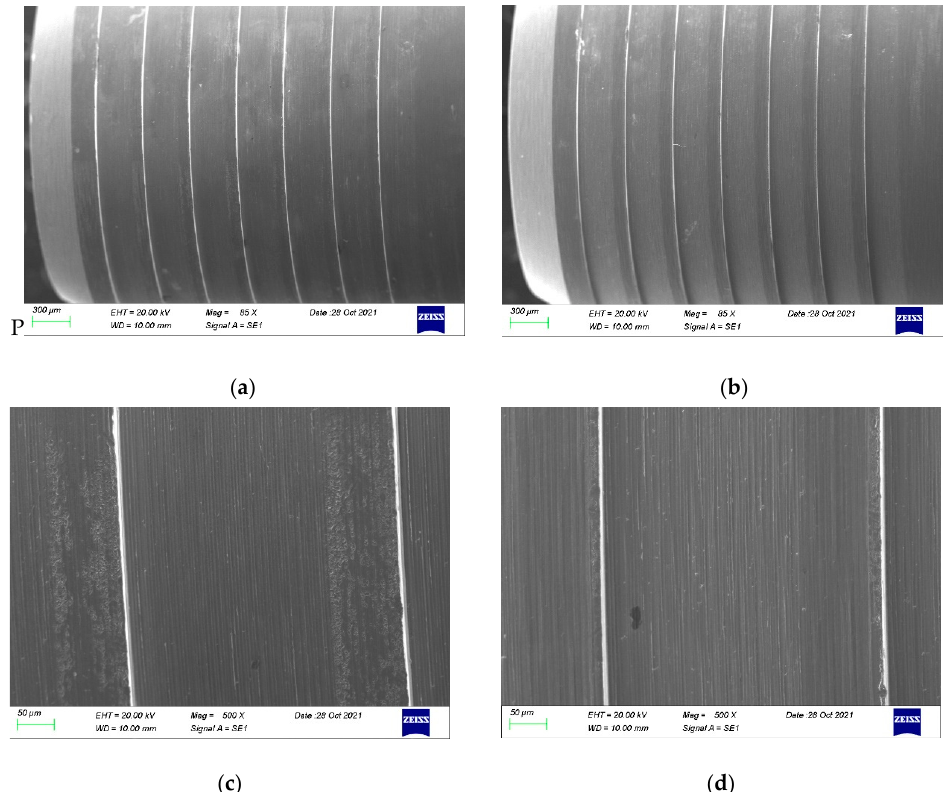
Figure 7. Anodized ( a , c ) and control ( b , d ) TBAs at 85 × ( a , b ) and 300 × ( c , d ). The black spot in Figure 7d is related to the electric charge in the dust on the specimen’s surface.